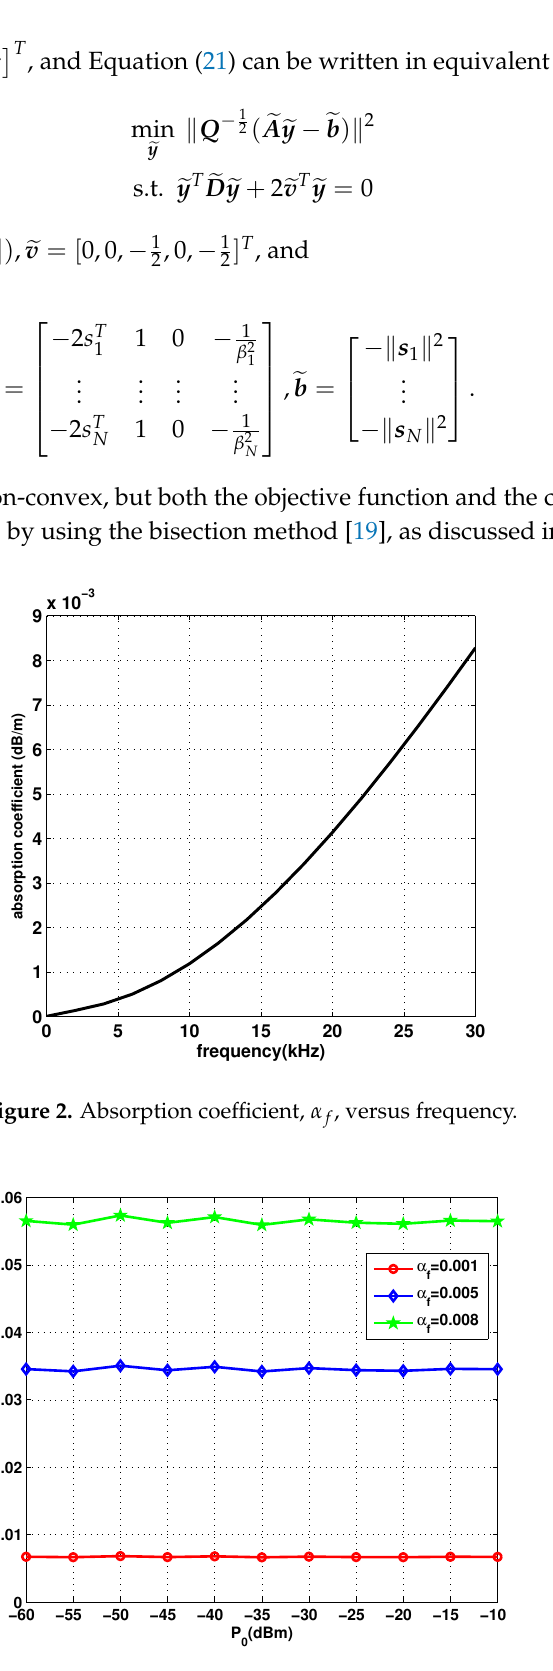
Figure 3. ν = α f ln10 η versus the transmit power P 0 in Equation (18) for several α f 10 γβ i